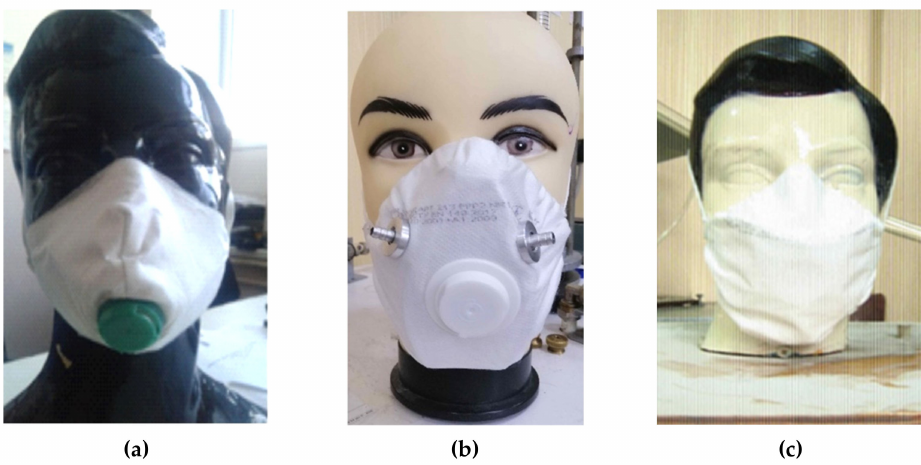
Figure 6. View of the FDR with a frame, with a variable geometry of half mask fitting to the worker’s face: ( a , b ) test samples; ( c ) reference